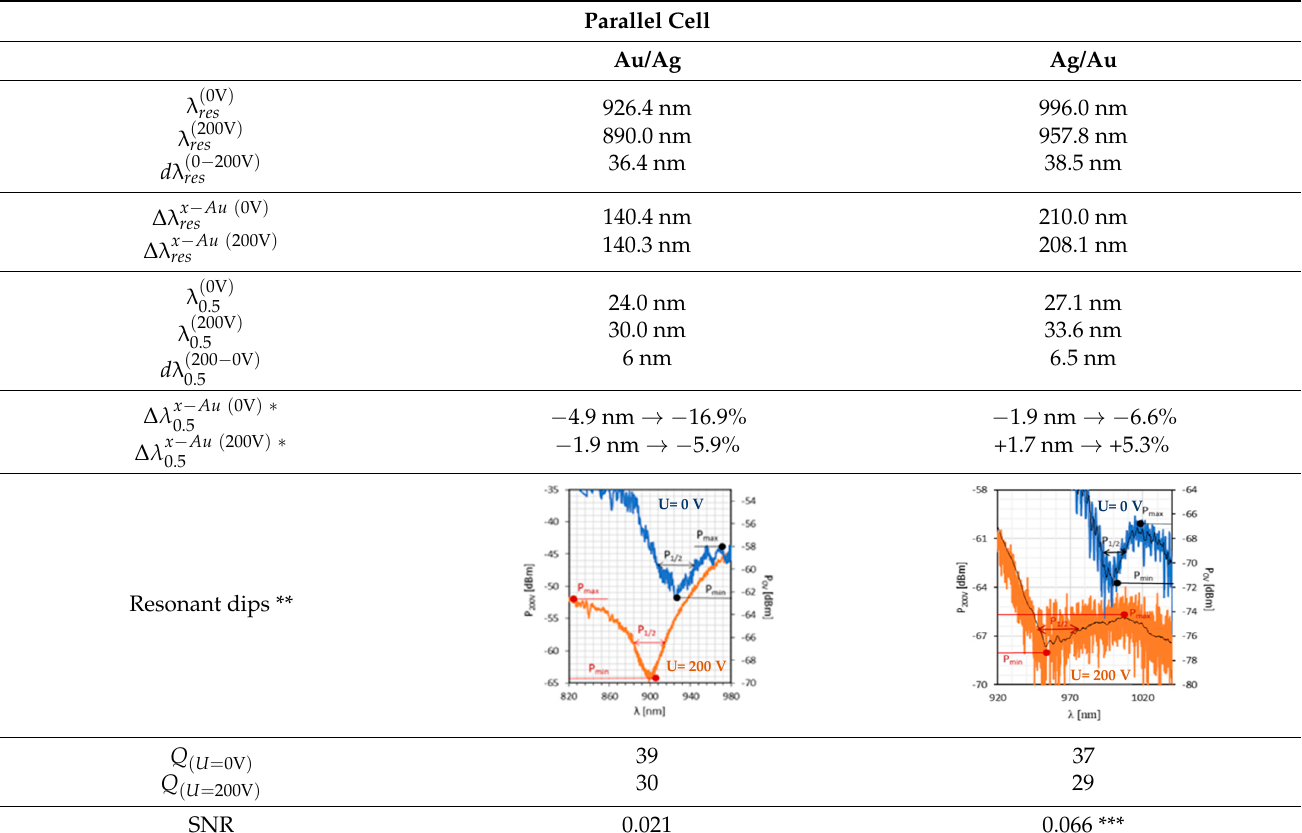
* Reduction in peak width relative to the Au layer; ** The solid lines are the fitting curves, *** Ap ‐ proximated parameter. Table 3. Comparison of resonant dips of a parallel cell. Parallel Cell Au/Ag Ag/Au